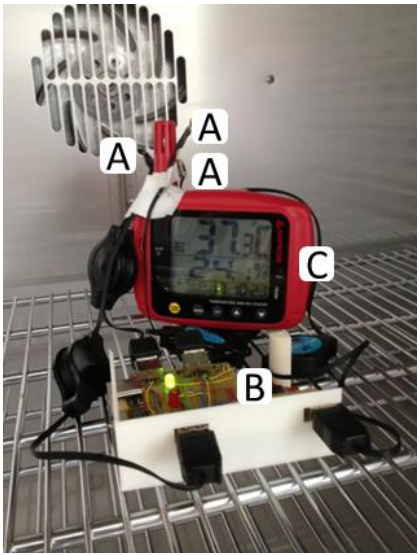
Figure 1. SHT21S sensors ( A ) connected to the Seeeduino Datalogger ( B ) and placed close to the sensing tip of the Amprobe TR300 ( C ) in the